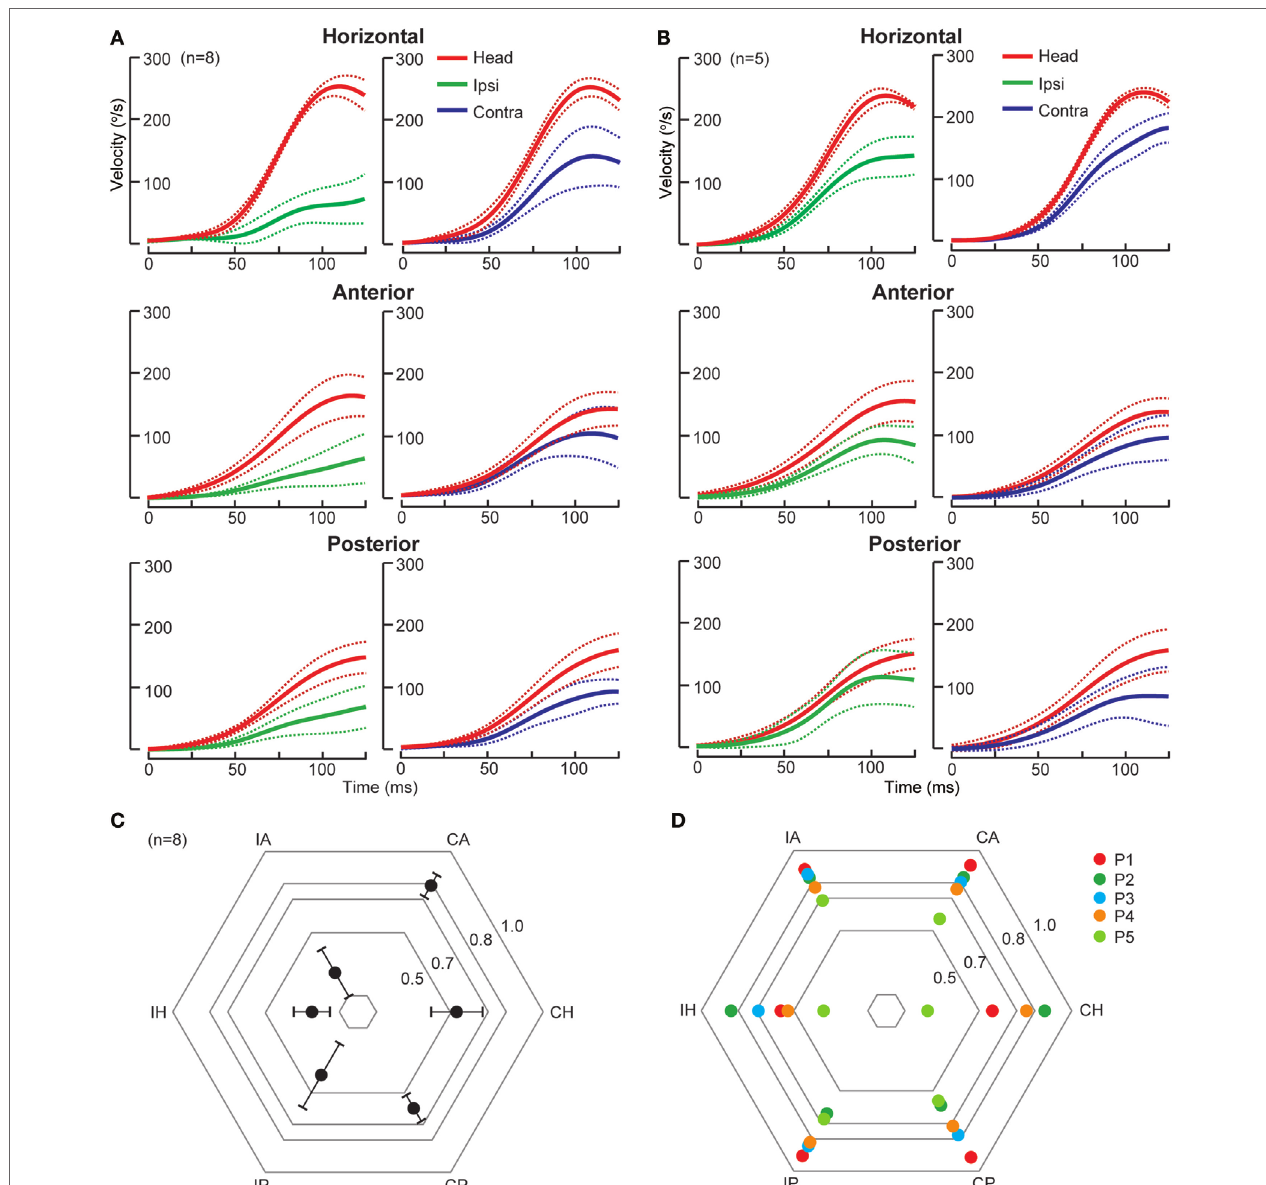
FiGURe 2 | Individual semicircular canal function in anterior inferior cerebellar artery (AICA) stroke. (A) In the first type of AICA stroke ( n = 8), group data displayed as time series of inverted eye and head velocities during the first 125 ms of head impulses, recorded using search coil HIT. Ipsilesional HC (gain 0.25 ± 0.10), AC (gain 0.24 ± 0.15), and PC (gain 0.39 ± 0.20) function was deficient, while only contralesional HC (gain 0.53 ± 0.14) but not AC (gain 0.79 ± 0.07) function was impaired. Contralesional PC function (gain 0.60 ± 0.08) function was slightly reduced, probably consistent with the severe ipsilesional AC deficit and reflects the on– off direction asymmetry. (B) In the second type of AICA stroke ( n = 5), there is mild bilateral symmetrical HC deficit while AC and PC function is preserved. Radar plots depicting mean gain ± 95% confidence interval for the first type of AICA stroke ( n = 8) and individual values for the second type of AICA stroke ( n = 5)